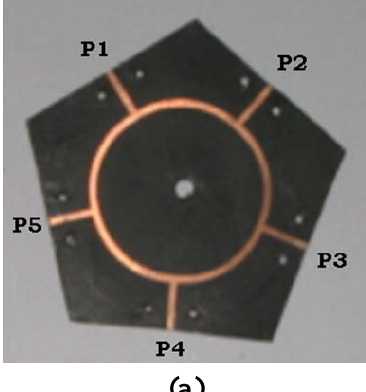
Figure 2. Five-port circuit. (a) Fabricated circuit; (b) Microwave Office